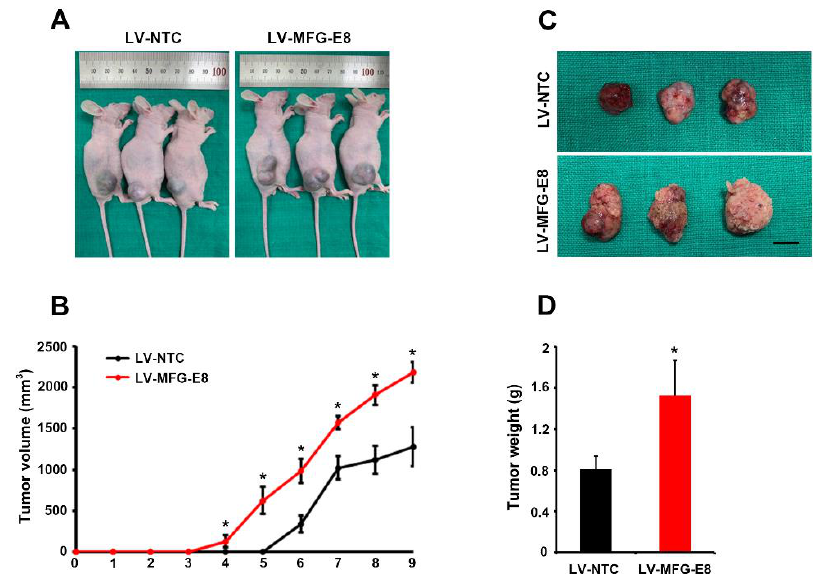
Figure 7. MFG-E8 overexpression promotes growth of HCC xenografts in vivo. ( A ) In vivo visualization of solid tumors in xenograft mice that received Huh7 cells transfected with LV-NTC or LV-MFG-E8. Images were taken 9 weeks after grafting. ( B ) Tumor volume was measured using a slide caliper every week for 9 weeks (n = 3 per group). ( C ) Dissected xenografts generated from Huh7 cells transduced either with LV-NTC or LV-MFG-E8. Scale bars, 10 mm. ( D ) Quantitative analysis of tumor weights 9 weeks after grafting.